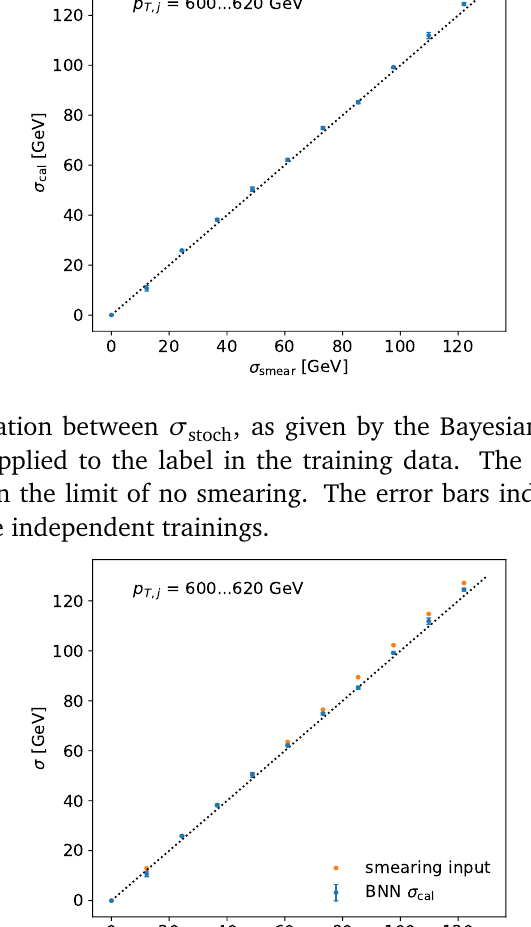
Figure 11: Comparison of the Bayesian approach, taken from Fig. 10 (blue), and smearing of input data (orange). When smearing the input data, we train a Bayesian network on nominal events and test it on inputs modified up and down by σ